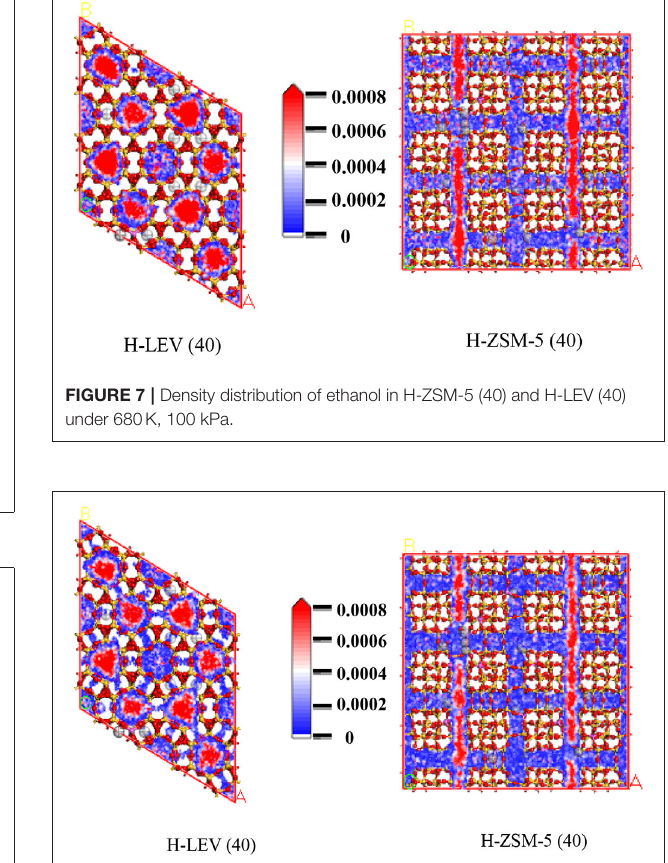
FIGURE 8 | Density distribution of ethylene in H-ZSM-5 (40) and H-LEV (40) under 680K, 100 kPa.